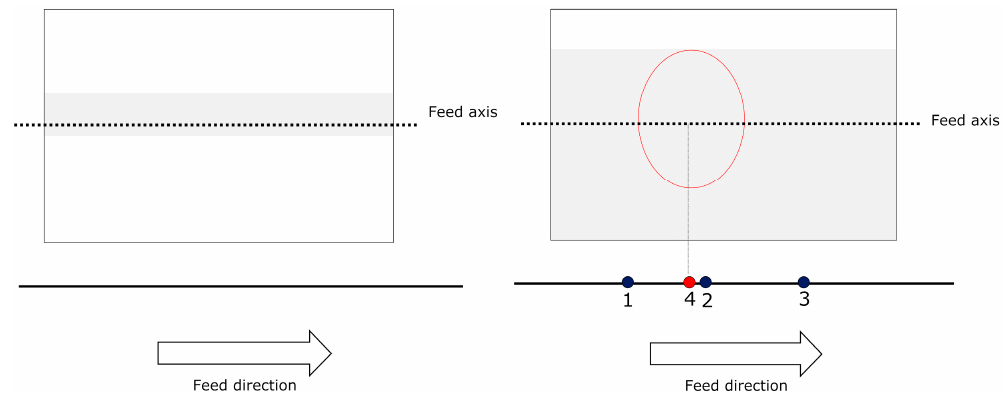
Figure 9. The “Enter” event occurs, and the system goes into the Can state.